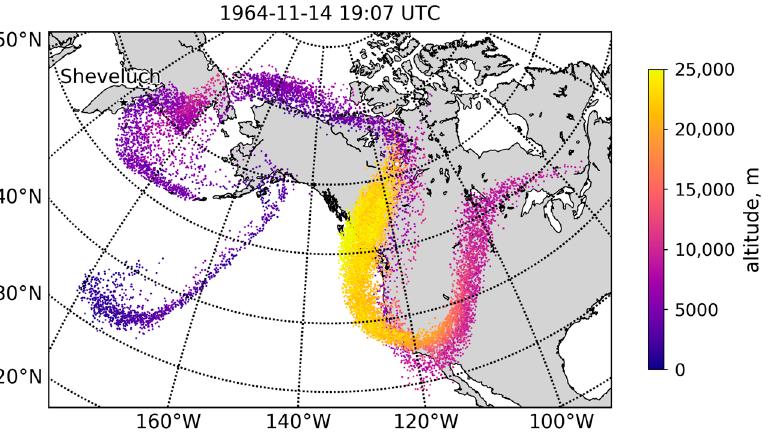
Figure 14. The visualization of the modeling results for the Sheveluch eruptive cloud as of 19:07 UTC, 14 November 1964.